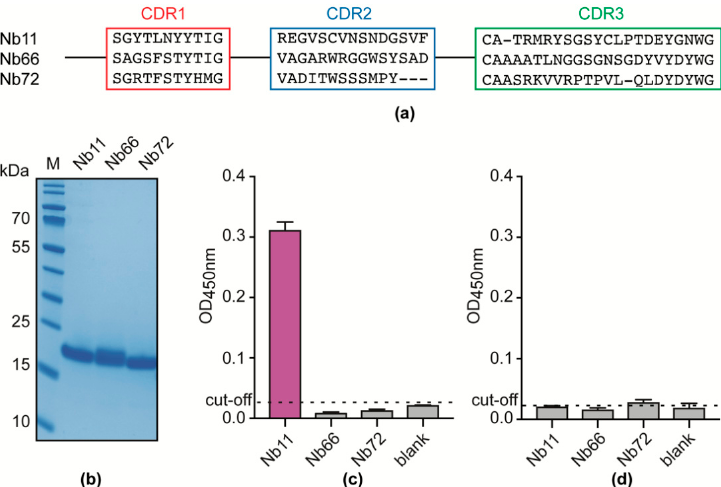
Figure 2. Identification of anti- T. evansi secretome Nbs. ( a ) Sequence alignment corresponding to CDR1, 2, and 3 regions of the anti- T. evansi secretome Nbs. ( b ) SDS-PAGE analysis of the identified Nbs after purification by IMAC and SEC. Lane M, PageRuler Prestained Protein Ladder. Indirect ELISA performed on T. evansi STIB806 secretome ( c ) and naïve mouse serum ( d ) with the retrieved Nbs. All ELISAs were performed in triplicate (error bars are shown) and the black dashed line refers to the ELISA cut-off (without Nbs as detecting agents).